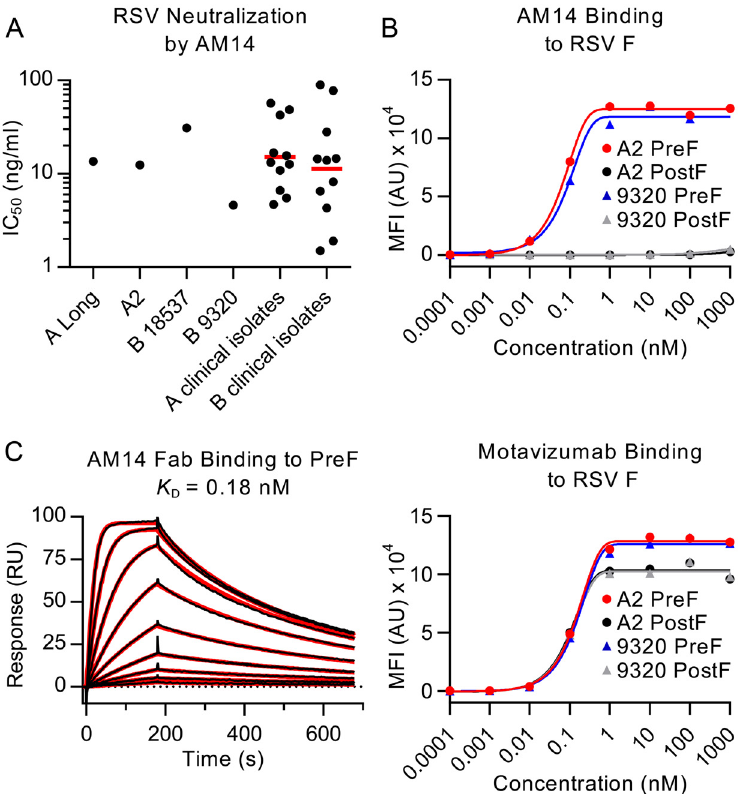
Fig 1. AM14 is a prefusion-specific neutralizing antibody. (A) Neutralization of laboratory strains and clinical isolates of RSV. Red bars are geometric means. (B) Binding of AM14 and motavizumab IgGs to immobilized RSV F proteins was measured using a Luminex system. (C) Binding of AM14 Fab to immobilized prefusion RSV F was measured by surface plasmon resonance. Best fit of the data to a 1:1 binding model is shown in